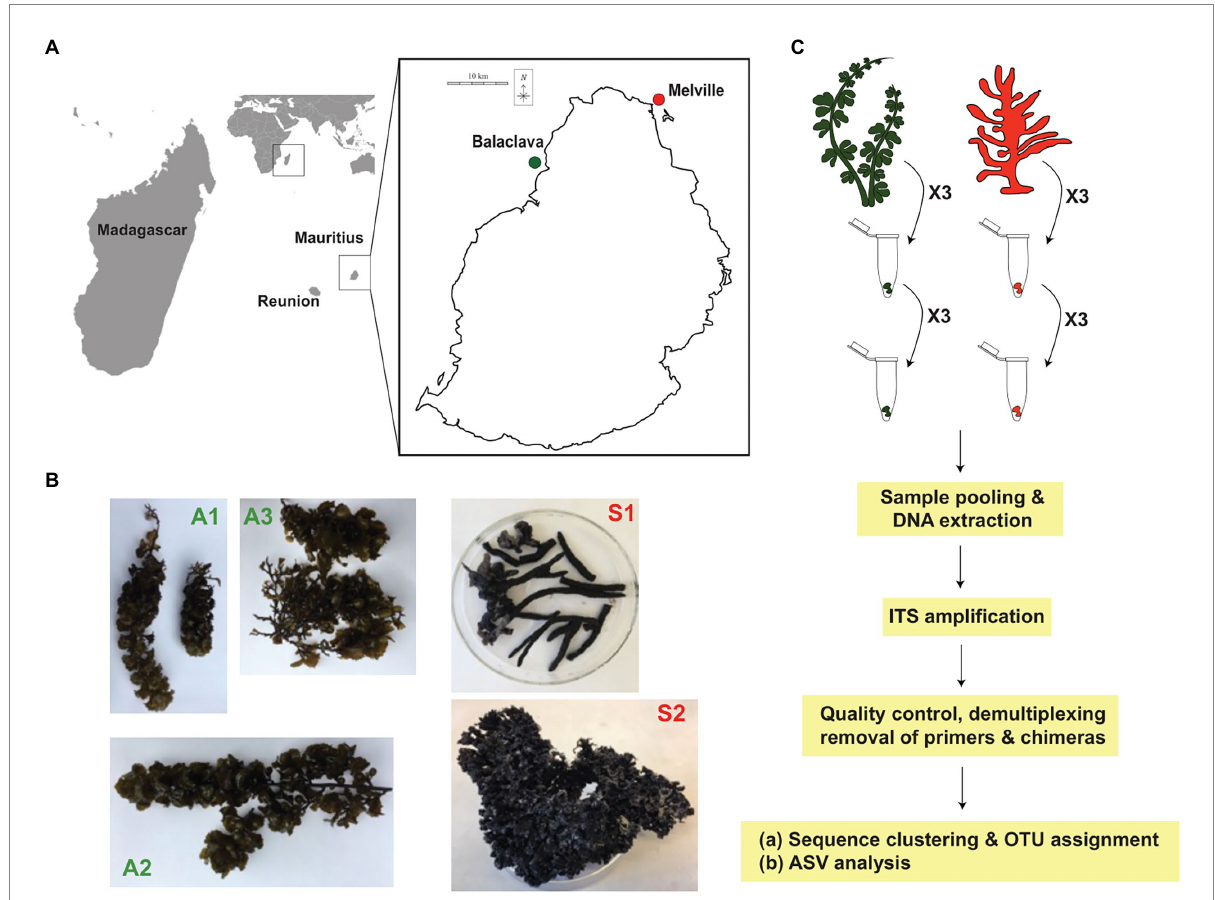
FIGURE 1 Samples collection in Mauritius and experimental design. (A) Red and green dots represent sites where sponge and algal samples were collected, respectively. (B) Brown algae (A1: Turbinaria conoides , A2: Sargassum pfeifferae , A3: Sargassum obovatum ), and sponges (S1: Iotrochota sp., S2: Biemna sp.) used in extraction of metagenomic DNA. (C) Experimental design and pipeline for data